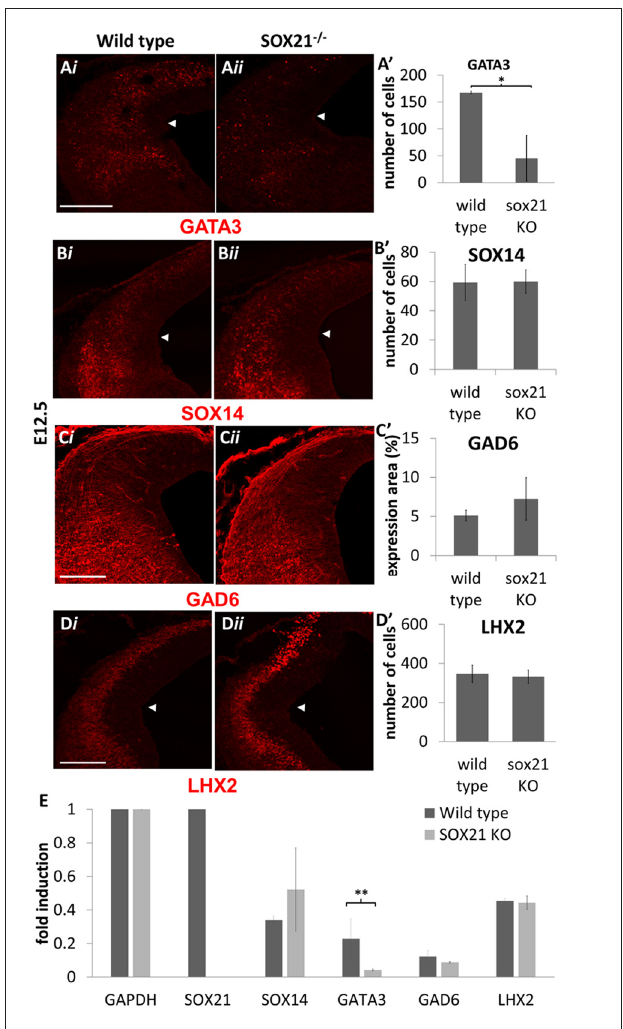
FIGURE 5 | Analysis of the GABAergic and glutamatergic lineages in SOX21 − / − embryos at E12.5. The immunostaining of the GABAergic marker GATA3 (A,A’) was shown to be reduced in the knockout embryos ( ii ) in comparison to the wild type ( i ). However, the expression of SOX14 (B,B’) and GAD6 (C,C’) as well as the glutamatergic marker LHX2 (D,D’) were not affected in the absence of SOX21. All nuclei were counted dorsally to the ventrolateral midbrain sulcus (indicated by white arrow). These data were confirmed by RT-Q-PCR analysis of embryos at the same age (E) . Data are represented as mean ± SEM. ∗ n = 10 (5 pairs of mice), P = 0.006, two-tailed Mann-Whitney test. ∗∗ n = 6 (3 pairs of mice), p = 0.042, DF = 1, Kruskal Wallis test. Scale bar, 150 µ